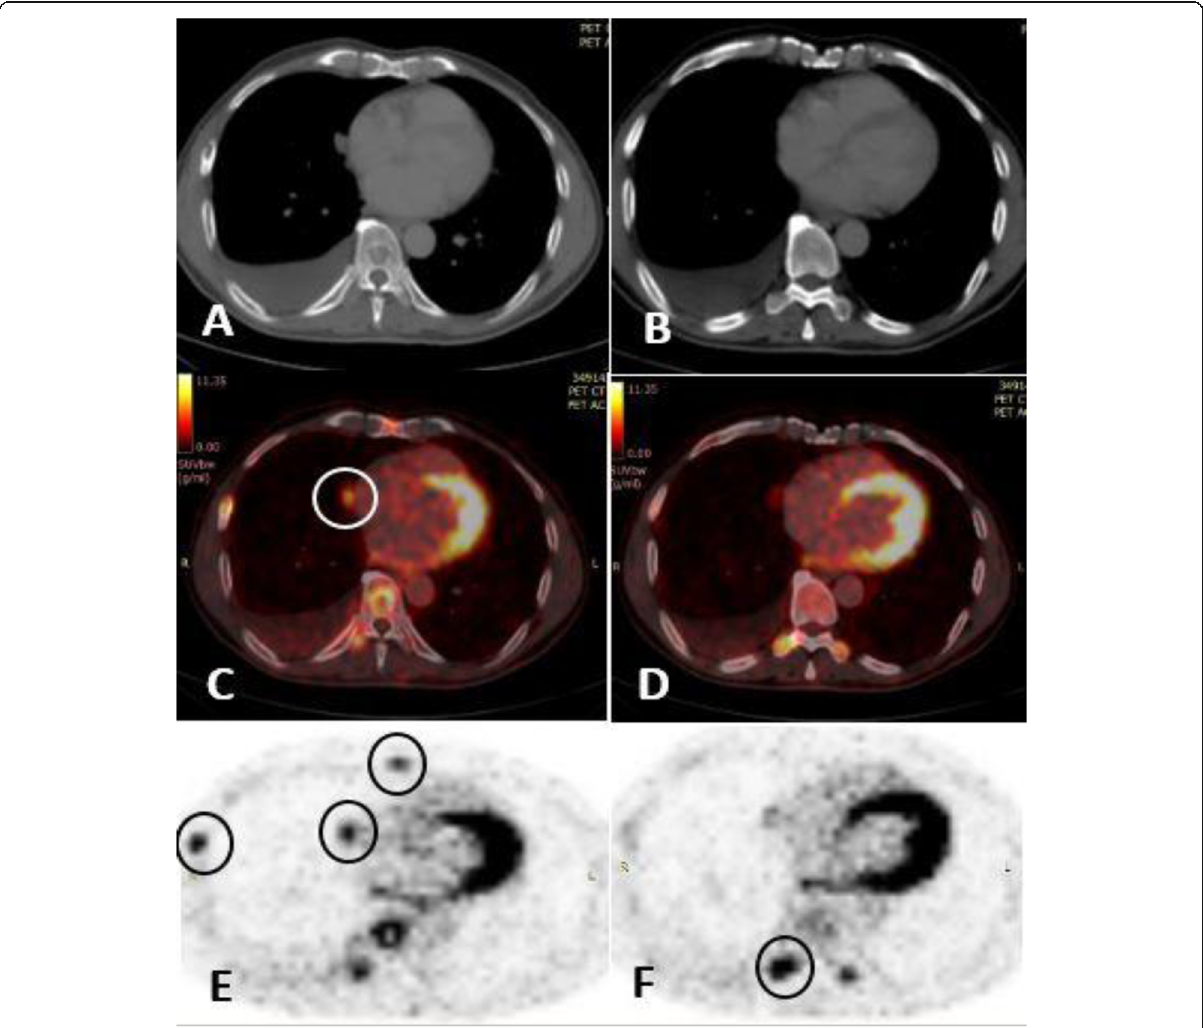
Fig. 5 A male patient 67 years old presented with dyspnea and attacks of hemoptysis and proven histopathologically to have NSCLC. CT study reveals a malignant mass lesion involving the right lower lobe = 3 cm considered as T1 with a small 5 mm pulmonary nodule involving the right middle lobe at the para-cardiac region ( a , b ) and considered by CT to be non-specific nodule. A bone study by CT was negative. PET/CT study reveals positive FDG uptake detected inside the pulmonary nodule (white circle c ) (T4), as well as positive active spots, noted affecting the thoracic bone namely the ribs, sternal body and the transverse process of the dorsal spine (M1c) (black circle) ( e , f ). The surgical staging of the patients by PET/CT changed from IIB to